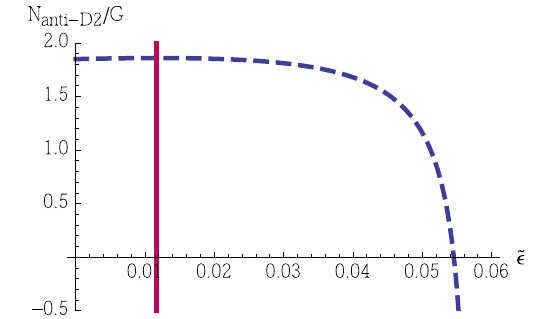
/ G in units of K α − 1 that deter- Fig. 2 The behavior of the ratio N D2 mines brane–flux decay. The smaller the ratio the more certain one can bethereisnodecay.Theregiontotherightoftheverticalredlinesuffers from closed string